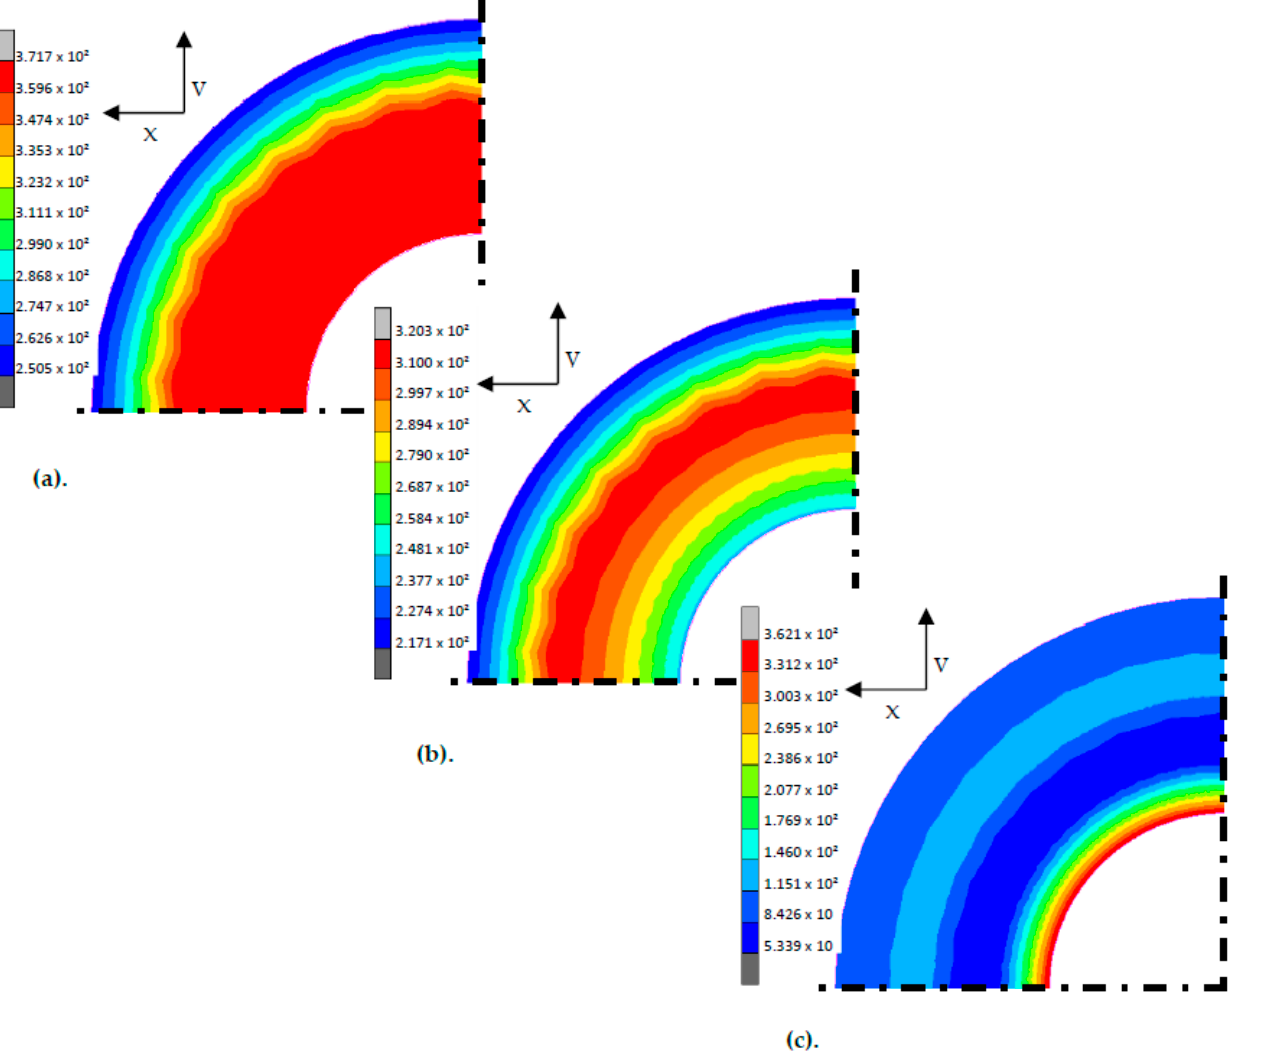
Figure 7. FE stress graphics (hub quarter section) of the equivalent stresses (GEH) for the load points K , G, and D [12]. ( a ) σ v at point K ; ( b ) σ v at point G ; ( c ) σ v at point D .